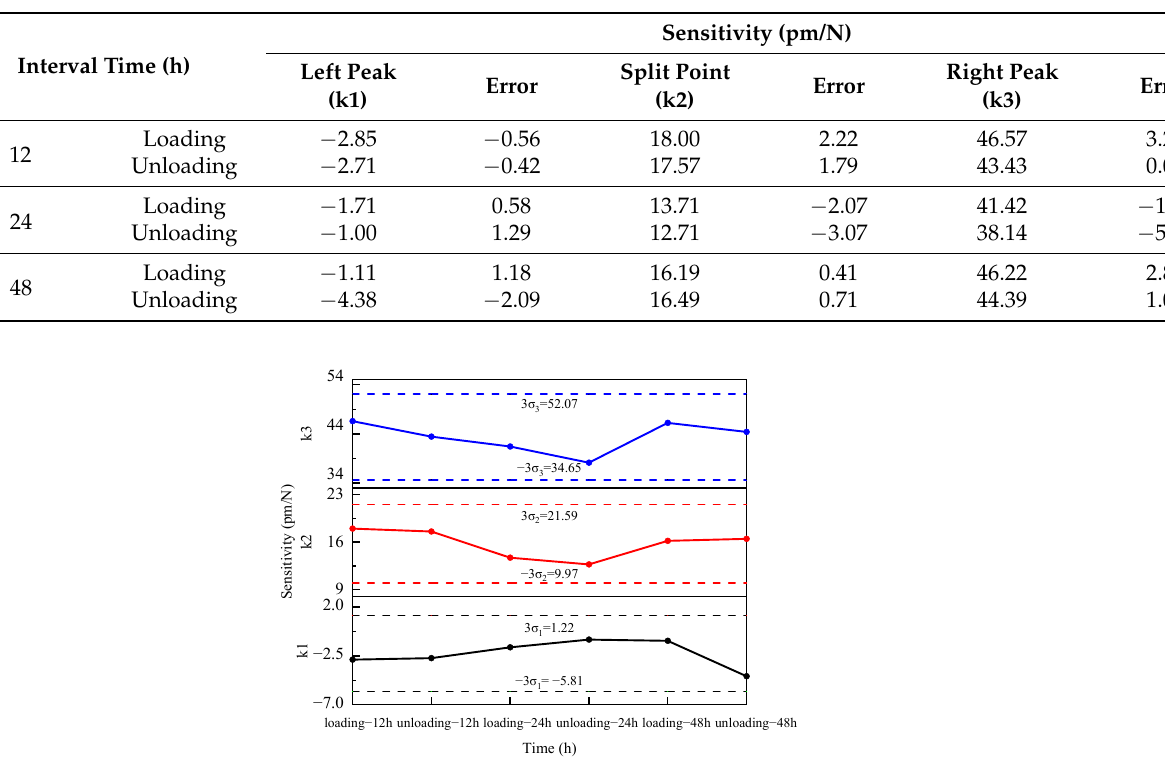
Table 3. Sensitivity of the left peak, split point and right peak after 12 h, 24 h and 48 h.